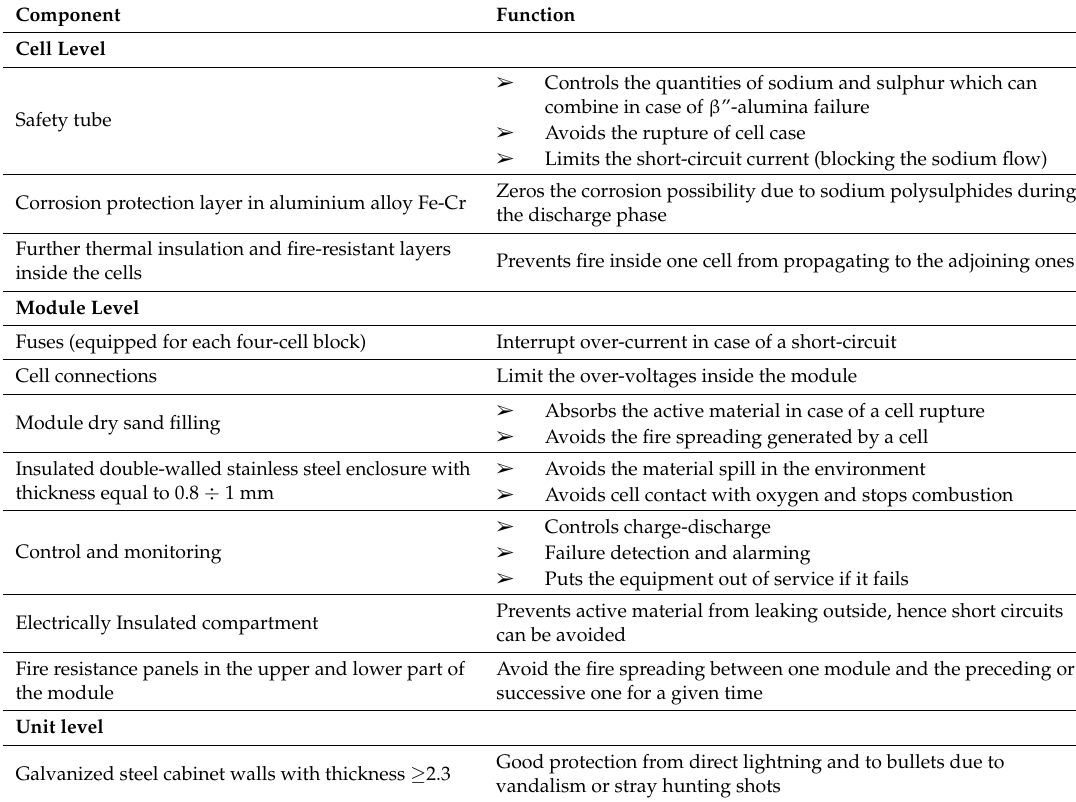
Table 1. Safety levels of the Na-S unit starting from the cell level.